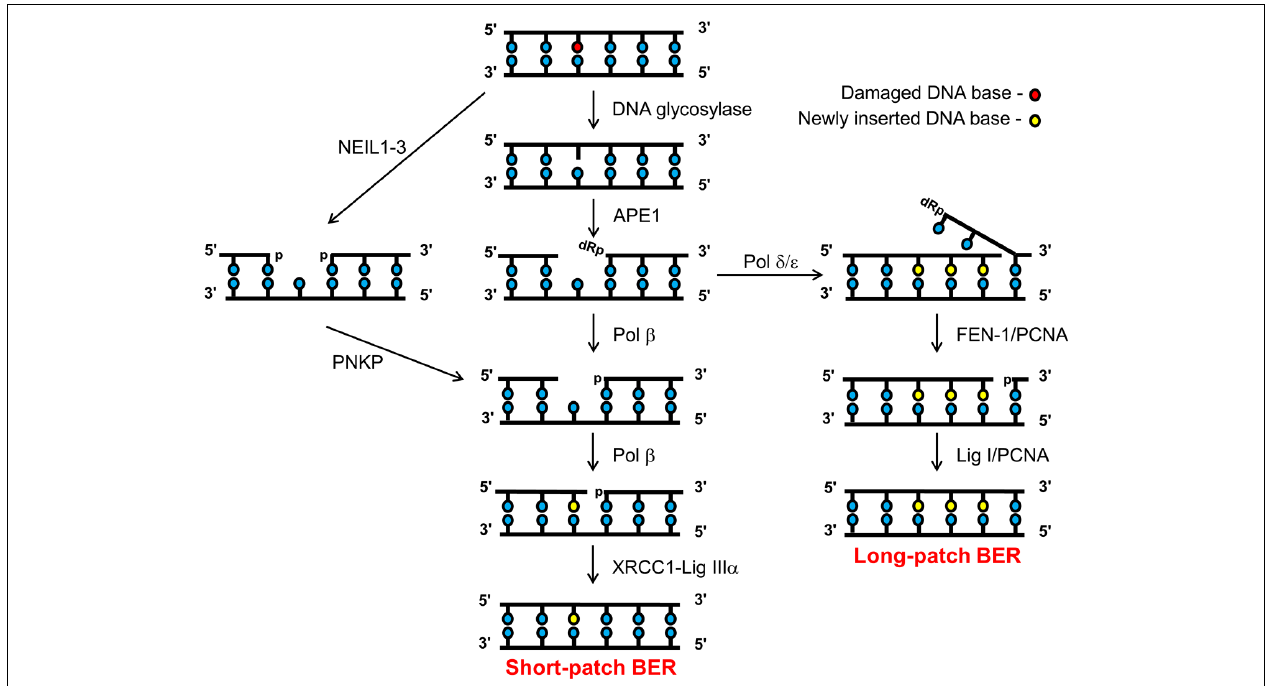
FIGURE 1 | Schematic of the BER pathway. Base excision repair (BER) is initiated by a damage specific DNA glycosylase that excises the damaged base to create an abasic site, which is then incised by APE1 creating a DNA SSB flanked by 3 (cid:3) -hydroxyl and 5 (cid:3) -dRP ends. Pol β cleaves the 5 (cid:3) -dRP moiety and simultaneously adds a single correct nucleotide into the one-nucleotide gap. Finally, the DNA SSB ends are sealed by the XRCC1-Lig III α complex, which completes the short-patch BER pathway (central branch). However, if the 5 (cid:3) -dRP moiety is resistant to cleavage by Pol β , then a polymerase switch occurs involving the recruitment of Pol δ / ε which